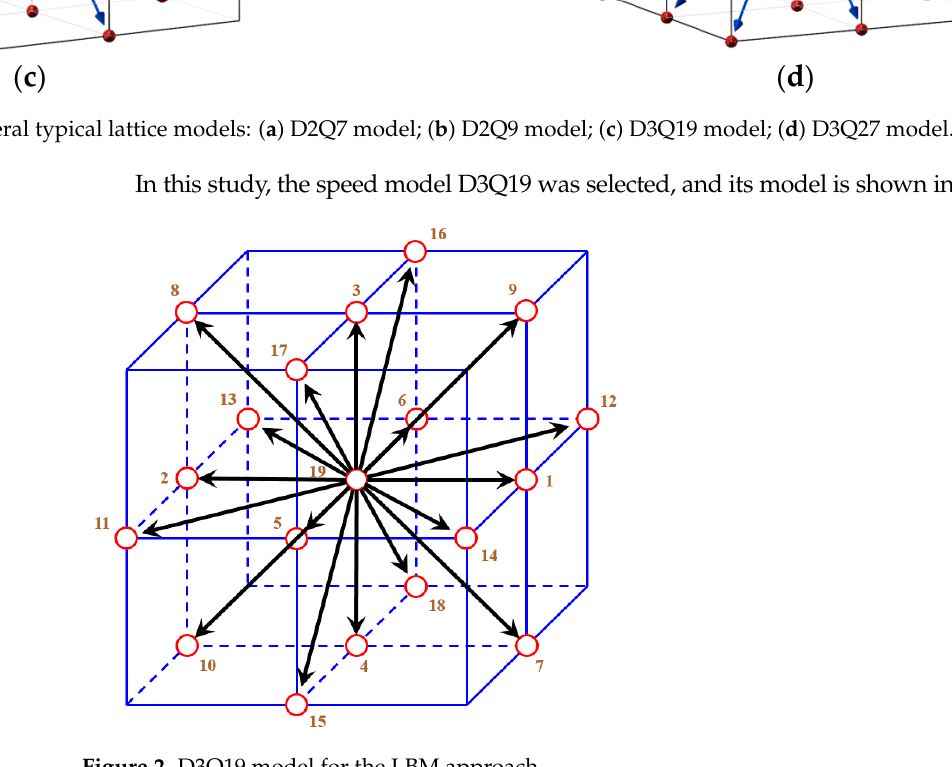
Figure 1. Several typical lattice models: ( a ) D2Q7 model; ( b ) D2Q9 model; ( c ) D3Q19 model; ( d ) D3Q27 model.